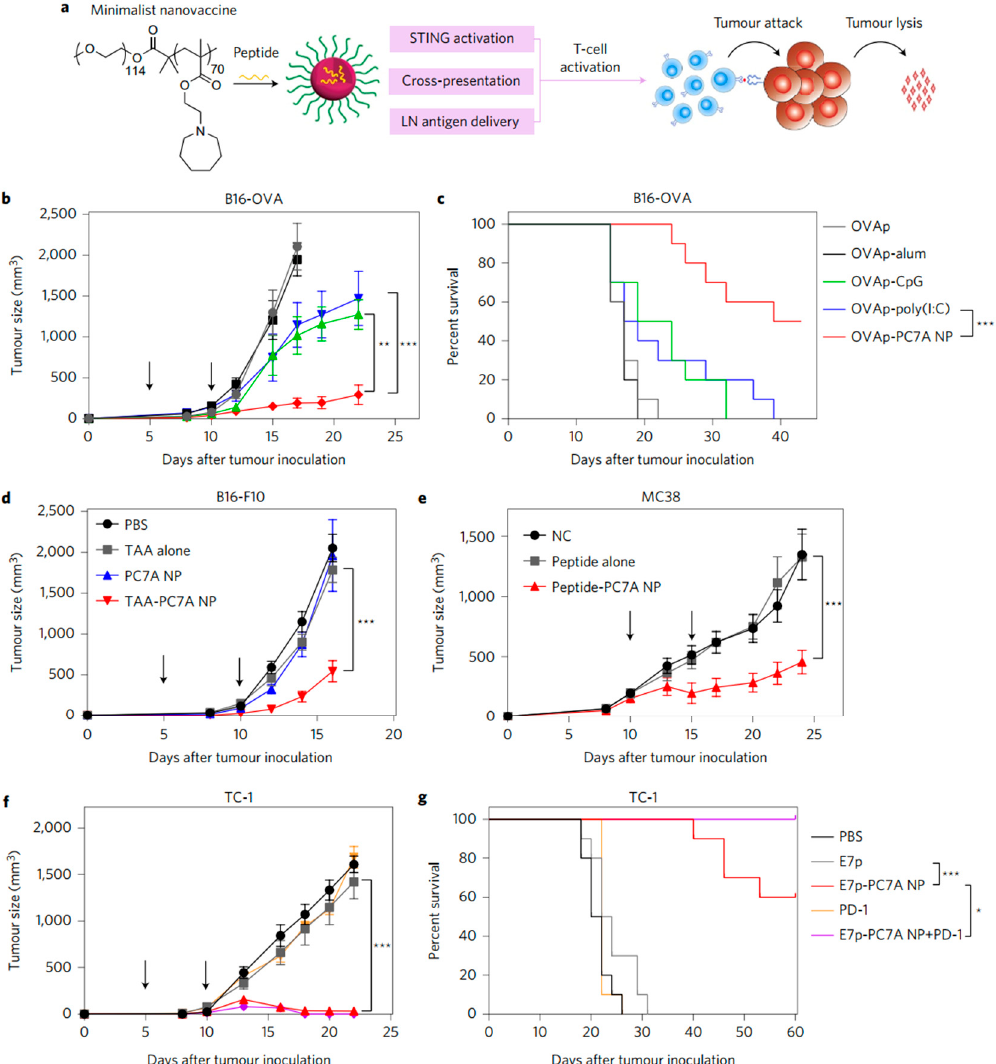
Figure 6. ( a ) Schematic of the minimalist design of the PC7A nanovaccine. ( b , c ) C57BL/6 mice ( n = 10 per group) inoculated with 1.5 × 10 5 B16-OVA tumor cells were treated with OVA peptide, PC7A nanovaccine, CpG, poly(I:C) and alum plus peptide (0.5 µg). Tumor growth ( b ) and Kaplan–Meier survival curves ( c ) of tumor-bearing mice are shown. ( d ) Tumor growth inhibition study of B16-F10 melanoma. C57BL/6 mice ( n = 10 per group) inoculated with 1.5 × 10 5 B16-F10 tumor cells were treated with a cocktail of tumor-associated antigens (Gp100 21–41 , Trp1 214–237 , Trp2 173–196 ) in PC7A NPs at specific time points, indicated by arrows. ( e ) Tumor growth inhibition study of MC38 colon cancer in C57BL/6 mice. Mice ( n = 10 per group) inoculated with 1.0 × 10 6 MC38 tumor cells were treated with a cocktail of neoantigens (Reps1 P45A , Adpgk R304M , Dpagt1 V213L ) in PC7A NPs,